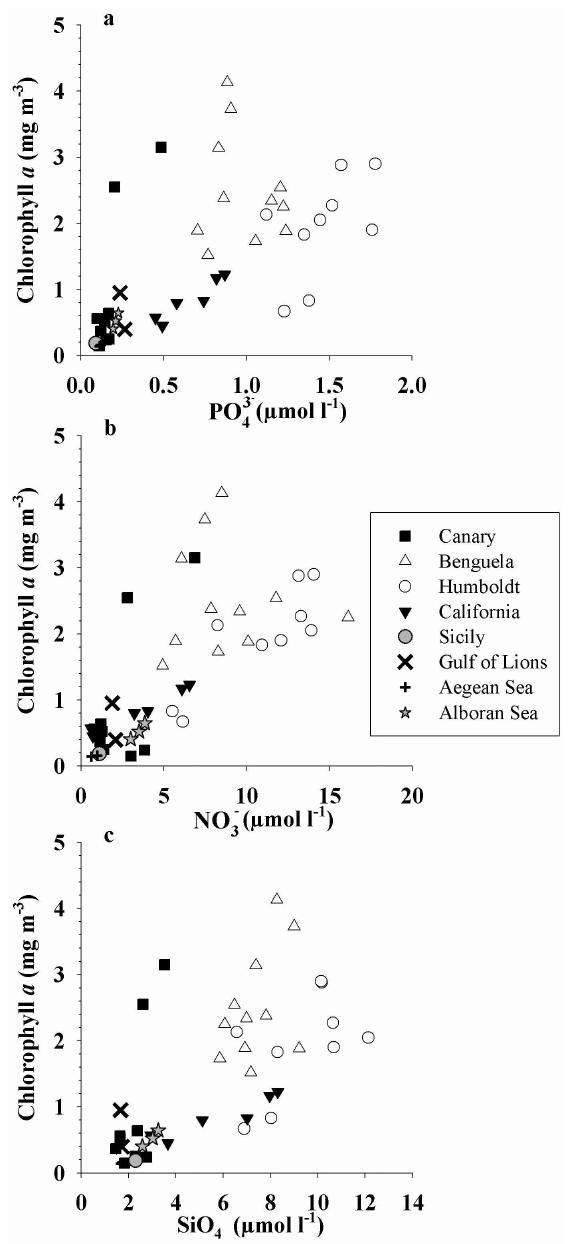
Fig . 8. – Relationships between mean annual phosphate (a), nitrate Fig . 7. – Relationships between mean annual phosphate (a), nitrate (b), and silicate (c) over the depth range 0-50 m and Ekman trans- (b), and silicate (c) over the depth range 0-50 m and Chl a . Medi- port. Mediterranean site data values are given in Table 1. Data on terranean sites’ data values are given in Table 1. Data on Canary, the Canary Islands, Benguela, Humboldt, and California EBUS Benguela, Humboldt, and California EBUS regions from Patti et regions from Patti et al . al . (2008).